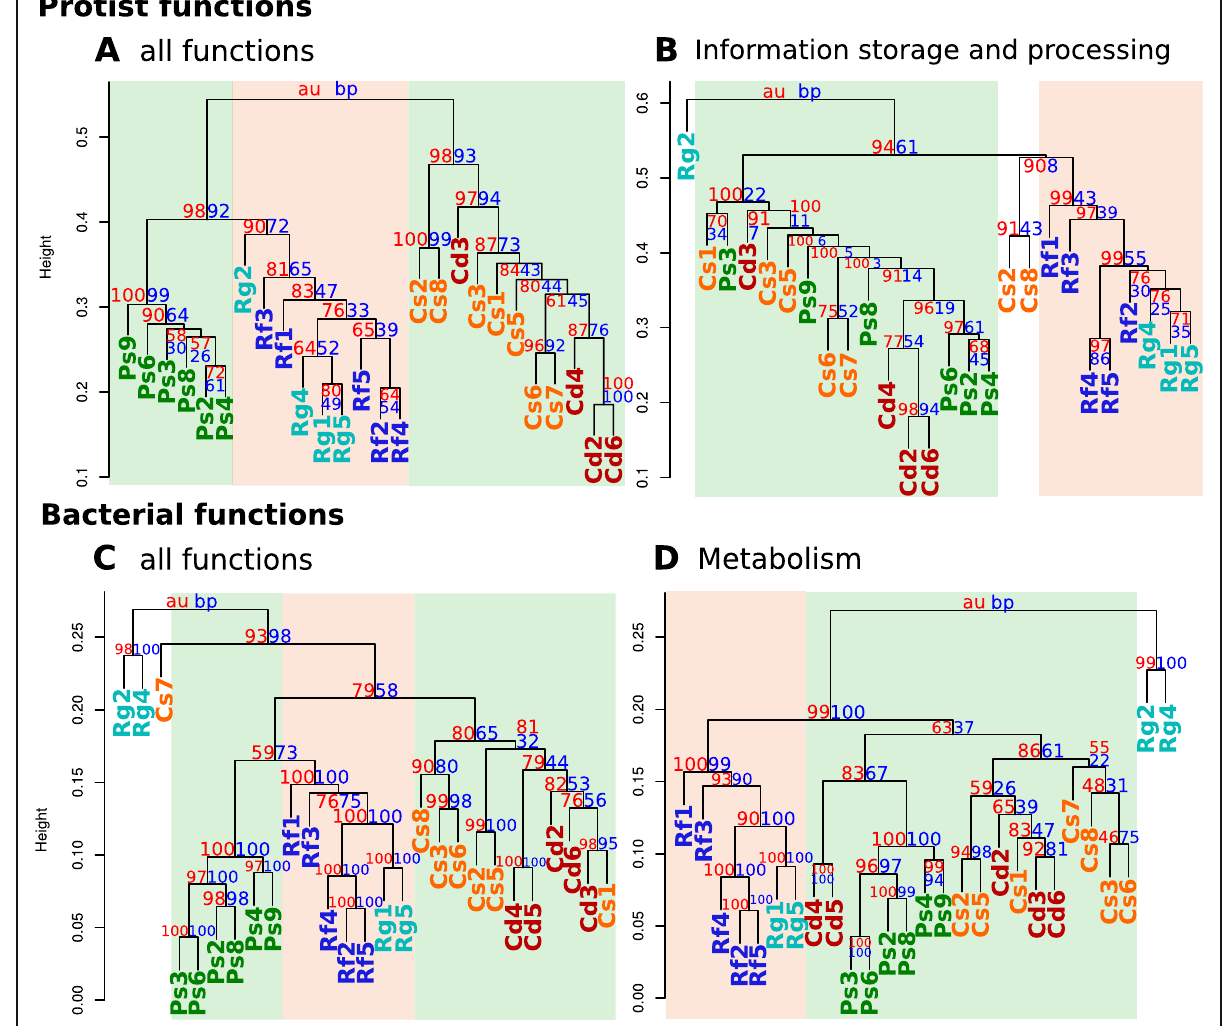
Fig. 2 Cluster dendrograms of the functional profiles of the protist and bacterial community. Community distances are based on Bray-Curtis Dissimilarities of a ) all functions of the protist community (25,795 sequences), b ) The category “ information storage and processing ” of the protist community (4527 sequences), c ) all functions of the bacterial community (21,215,480 sequences), and d ) the category “ metabolism ” of the bacterial community (10,586,058 sequences). Cd (red) = C. domesticus colonies; Cs (orange) = C. secundus colonies; Ps (green) = P. simplex colonies; Rf (blue) = R. flavipes colonies; Rg (lightblue)= R. grassei colonies. Green background = wood-dwelling life types; orange background = foraging life type. For protist functions involved in “ information storage and processing ” in the protist community, samples clustered according to life type. Similarly, the bacterial metabolic metagenomes clustered according to life type. Cluster dendrograms of all functional categories of protist and bacterial communities can be found in Additional file 1: Fig. S4 and